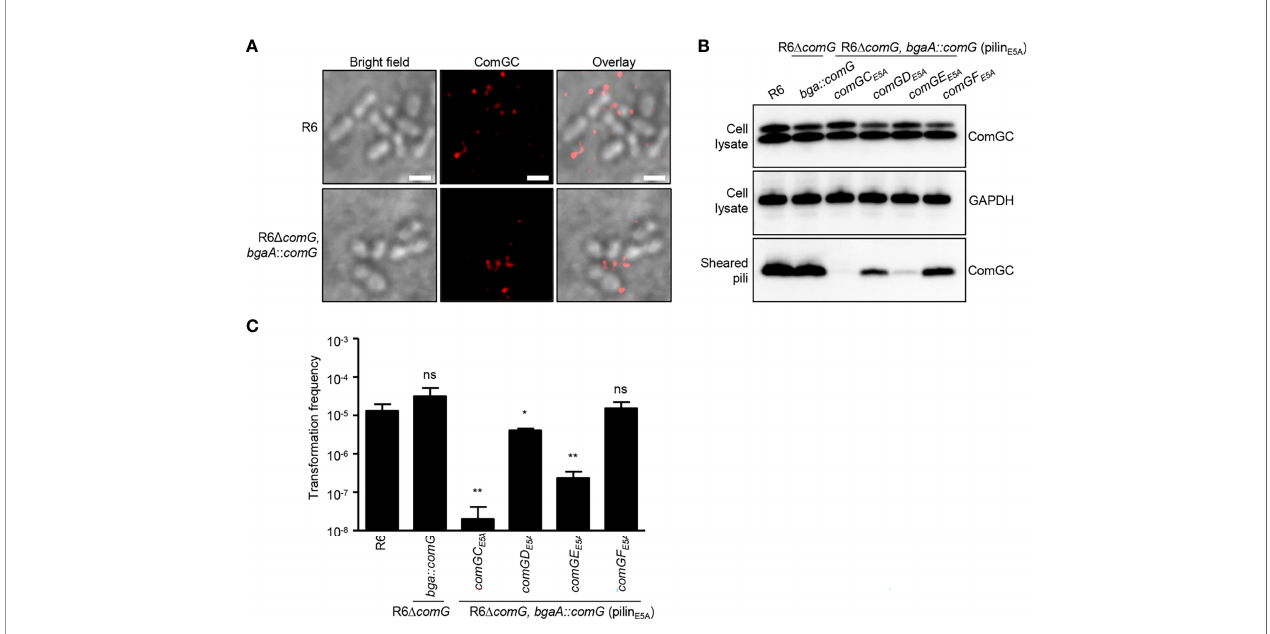
FIGURE 6 | E5A mutations affect minor pilin function of ComGD and ComGE. (A) Visualization of competence-induced pili in WT R6 and R6 D comG, bgaA :: comG complemented strain by IF microscopy. Bacteria were visualized by bright fi eld microscopy and competence pili were labelled with antibodies speci fi c for ComGC (red). Scale bars represent 2 µm. (B) ComGC was detected by immunoblotting in bacterial whole cell lysates and sheared pili of E5A mutant strains ( comGC E5A , comGD E5A , comGE E5A or comGF E5A ). The WT R6 strain and the complemented mutant strain in which the native comG operon was expressed ectopically (R6 D comG , bgaA :: comG ) were included as positive controls. GAPDH was used as a loading control. (C) Transformation frequency of WT R6 strain, R6 D comG , bgaA :: comG complemented mutant and E5A mutant strains. The error bar represents the standard deviation of a minimum of three independent experiments. A t- test was used for statistical analysis: * p ≤ 0.05 and ** p ≤ 0.01, ns, no signi fi cant difference ( C E5A p = 0.0043 ; D E5A p = 0.0237 and E E5A p =